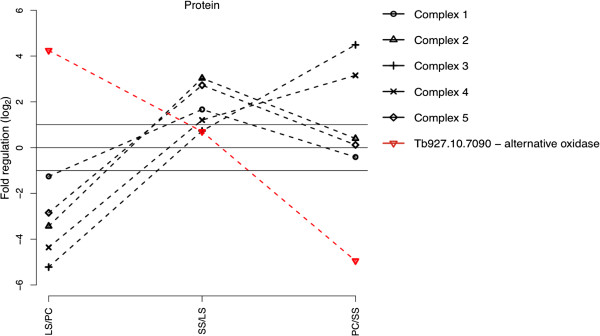
Protein expression profile of the oxidative phosphorilation complexes I-V during development. X-axis indicates the fold regulation (log2) of the complexes based on the mean fold change of the individual components.